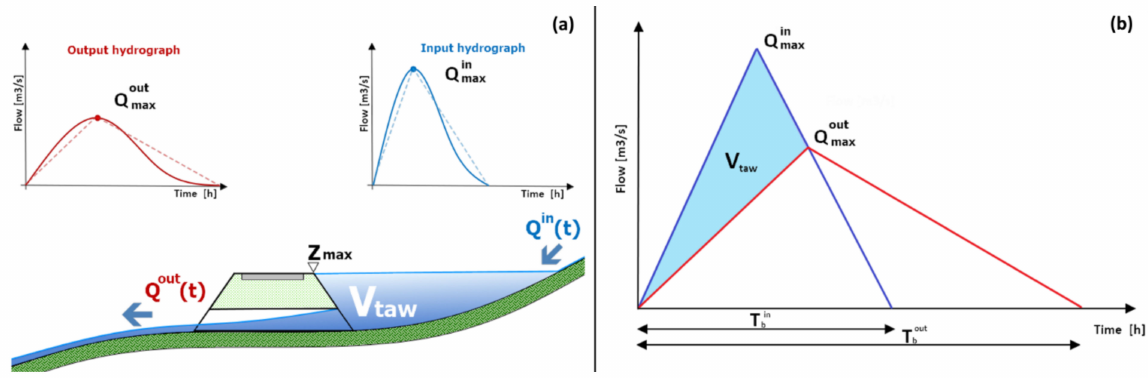
Figure 6. ( a ) Schematization of the hydrograph transformation model and ( b ) the triangular approximation of the inlet and outlet